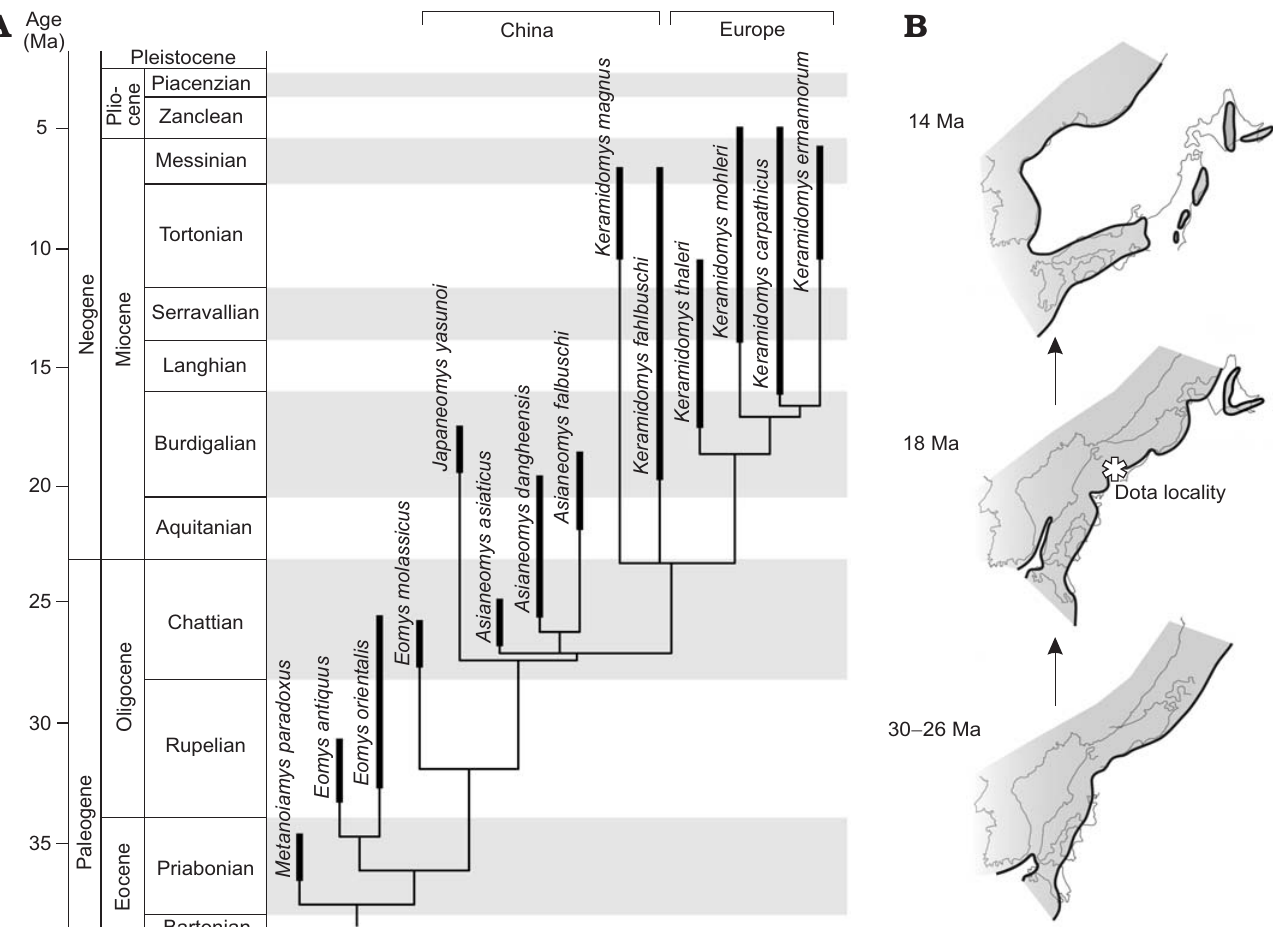
Fig. 5. Time-scaled phylogeny of eomyid rodents and paleogeography of Japan. A . Time-scaled 50% majority-rule tree of eomyid rodents, using the “equal” scaling method. B . Schematic paleogeography of the eastern margin of Asia from the Oligocene to the middle Miocene. Noda and Goto (2004) and NUMO (2004) were referred for the schematic figure, both of which compiled paleogeographic and tectonic information from the primary literatures cited therein. Black lines with shaded area indicate shorelines and land masses. Light gray lines show current coastlines of both Japan and east Asia. Note that Japan was part of the continent during the late Oligocene and progressively drifted during the Miocene. More details are provided in the